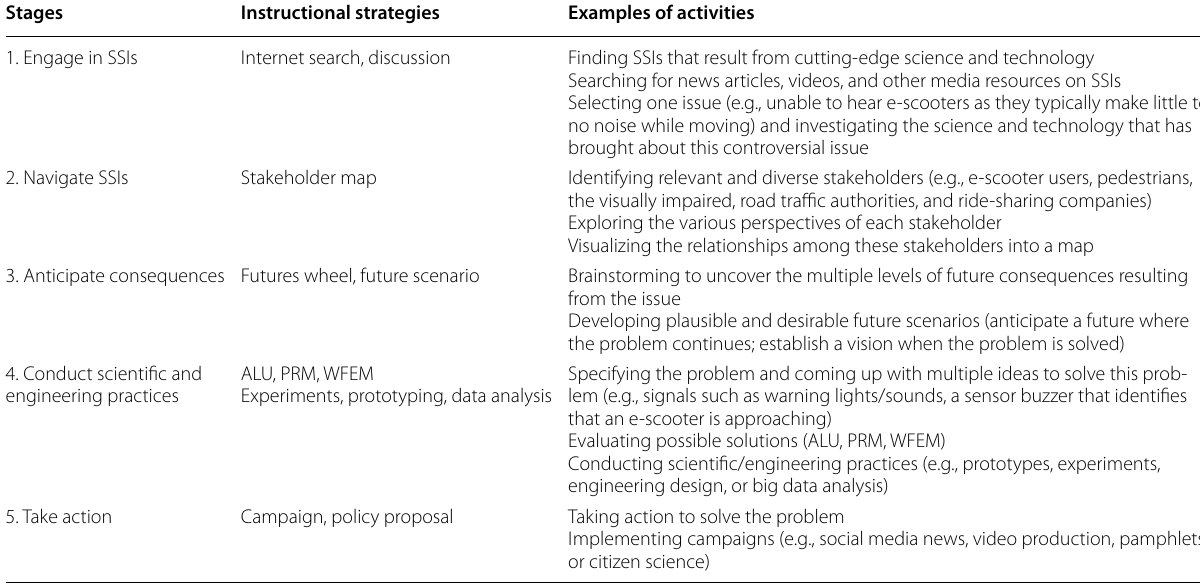
Table 1 An example of the ENACT program Stages